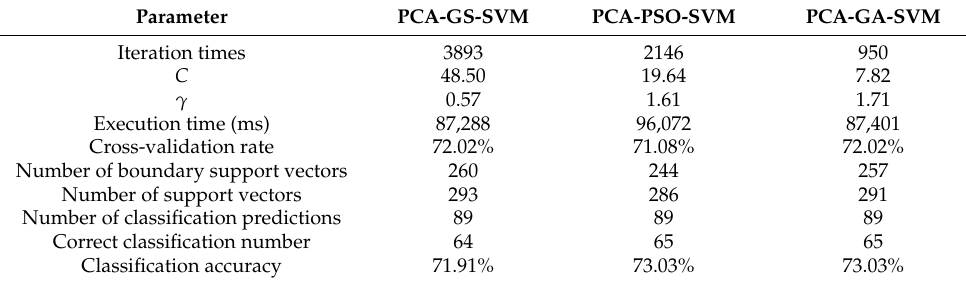
Table 4. PCA-1~PCA-5 parameter values using different